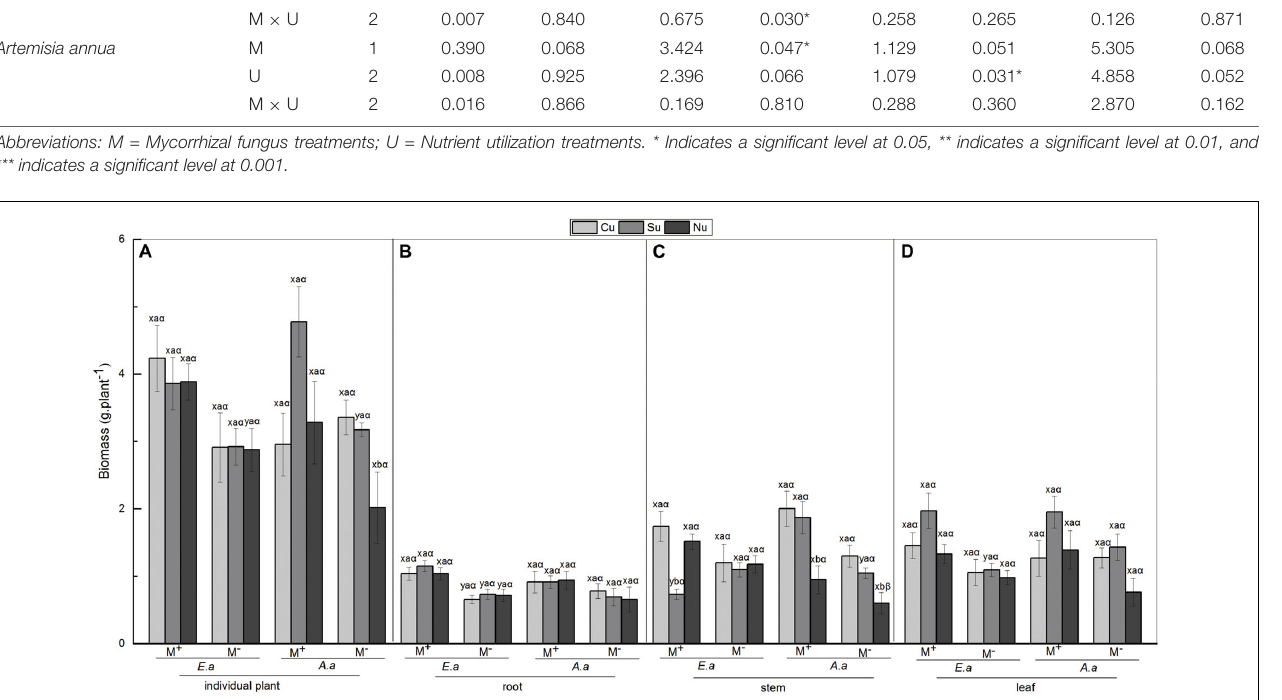
TABLE 2 | Two-Way ANOVAs for the effects of mycorrhizal fungus (M + vs M − ) and nutrient utilization treatments (Cu vs Su vs Nu) on biomass of the invasive plant Eupatorium adenophorum and the native plant Artemisia annua . Plant species Factors df Biomass Root Stem Leaf Individual plant F P F P F P F P